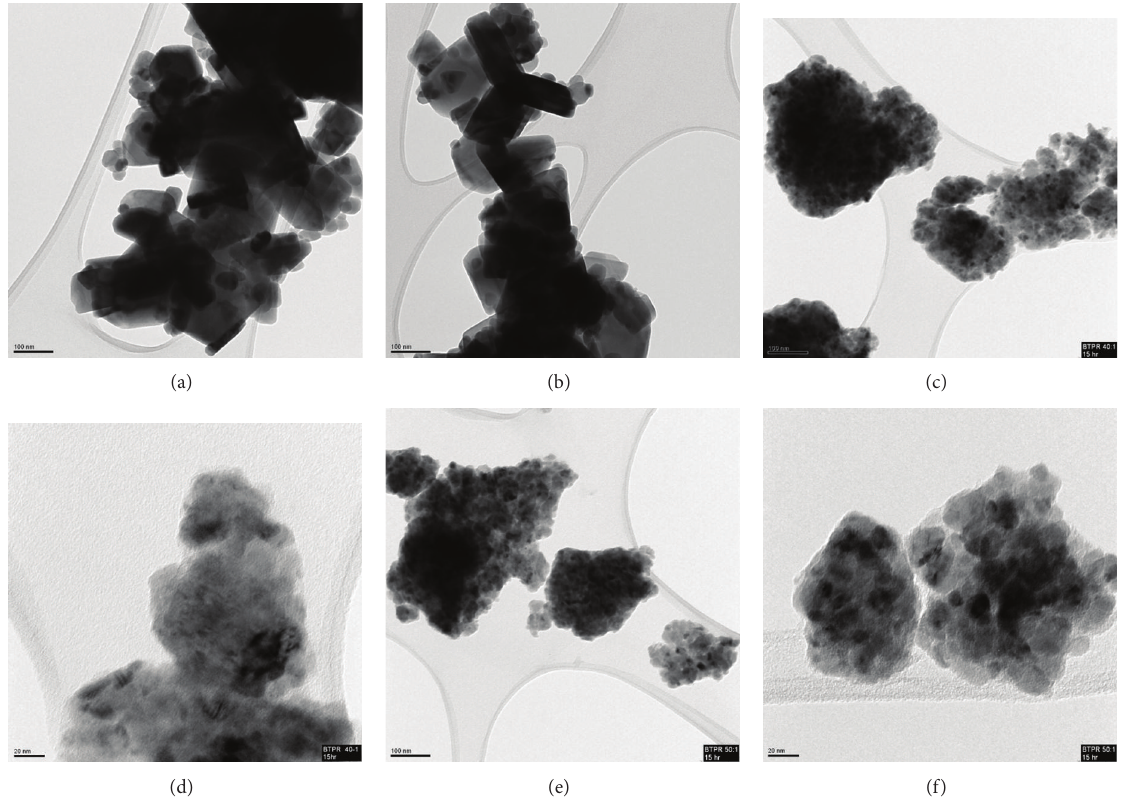
Figure 7: Low magnification transmission electron micrograph (TEM) of pure magnetite (a and b) at 100nm magnification, (c) TEM image at BPR 40: 1, (100nm) and (d) (20 nm). (e) TEM image at BPR 50: 1, (100nm) and (f)